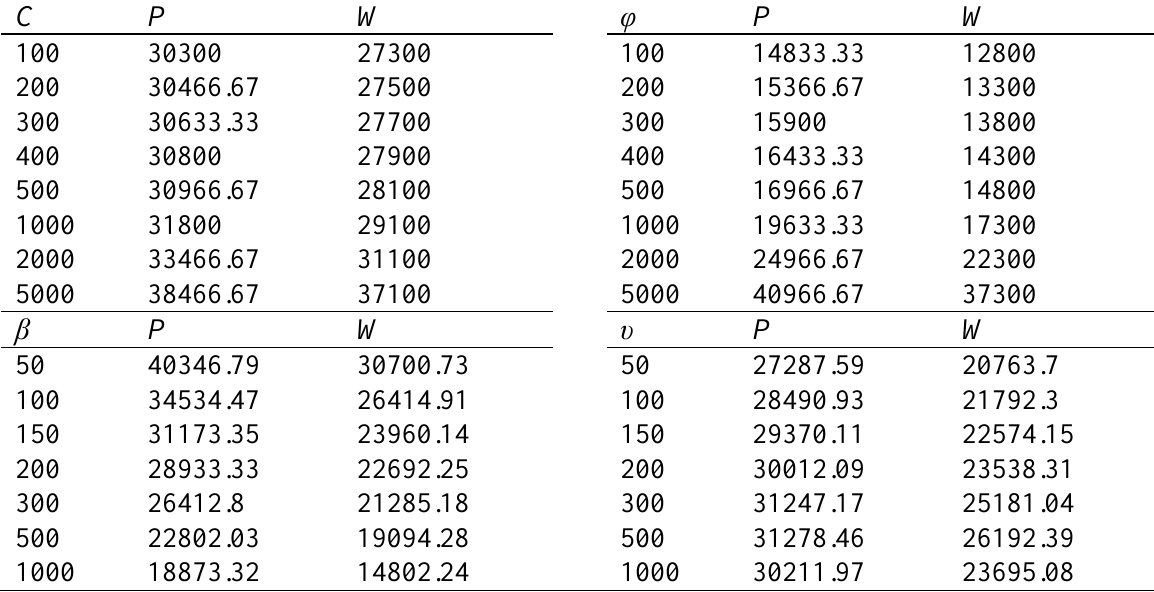
Table 2. Detailed derived data for different sensitivity analyses.